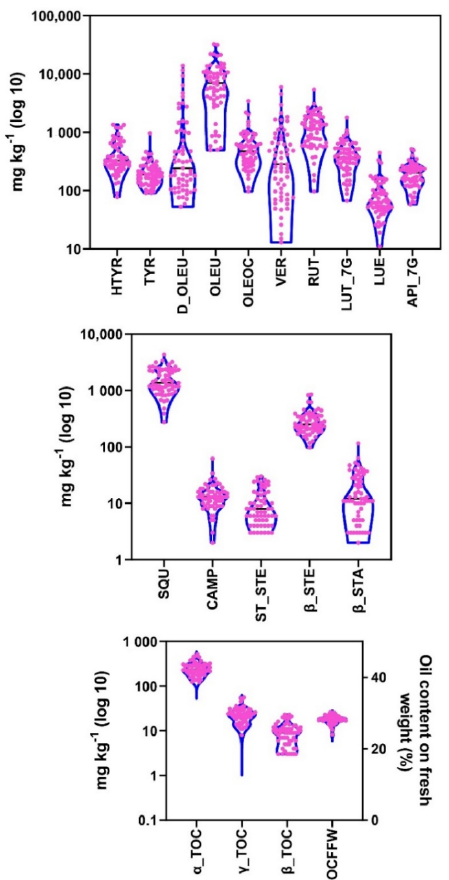
Figure 2. Violin graphs representing trait variation between two consecutive crop seasons. Each plot shows the distribution of data for 61 cultivars from the minimum to the maximum level, with hori ‐ zontal inner line showing the data median. The horizontal width of the violin depends on the data density. The pink circles represent the 61 olive cultivars. The data are expressed as mg kg ‐ 1 of fruit pulp. The analyzed traits included phenols—hydroxytyrosol (HTYR), tyrosol (TYR), deme ‐ thyloleuropein (D_OLEU), oleuropein (OLEU), oleocanthal (OLEOC), verbascoside (VER), rutin (RUT), luteolin ‐ 7 ‐ glycoside (LUT_7G), luteolin (LUE), apigenin ‐ 7 ‐ glycoside (API_7G); squalene and sterols—squalene (SQU), campesterol (CAMP), stigmasterol (ST_STE), β‐ sitosterol ( β _STE), β‐ sitostanol ( β _STA); tocopherols— α‐ tocopherol ( α _TOC), γ‐ tocopherol ( γ _TOC), β‐ tocopherol ( β _TOC); and oil content on fruit fresh weight (OCFFW).